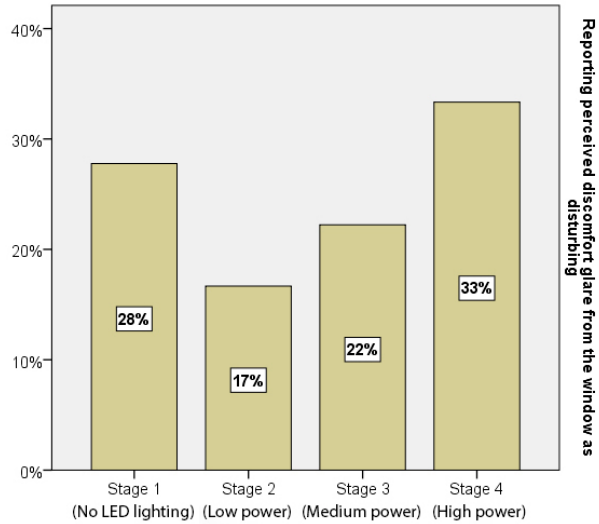
Figure 5. Percentage of participants reporting discomfort glare as disturbing during each lighting condition.